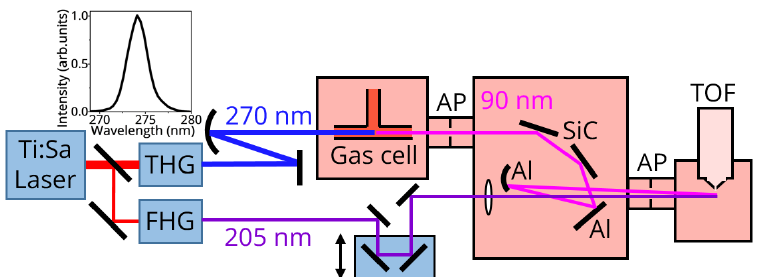
Figure 2. Schematic illustration of the experimental setup for vacuum-ultraviolet time-resolved photoelectron spectroscopy (VUV TRPES) using 205-nm pump and 90-nm probe pulses. THG: Single-pass third-harmonic generation stage; FHG: Fourth-harmonic generation using nonlinear crystals; AP: Apertures for differential pumping; SiC: SiC Brewster-angle beam splitters; Al: Bare aluminum mirrors; TOF: Magnetic-bottle time-of-flight photoelectron spectrometer. The inset shows the THG spectrum.